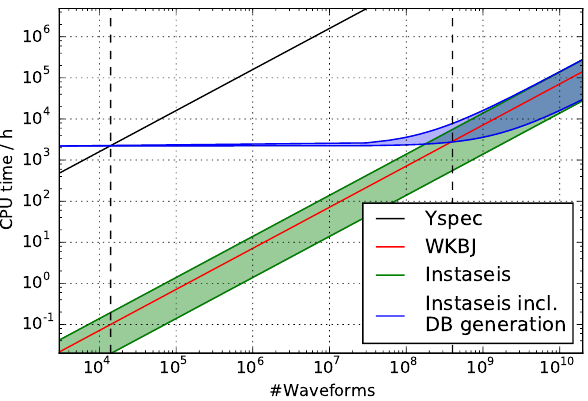
Figure 18. Computational cost to compute many synthetic seismo- grams for finite-frequency tomography with a shortest period of 2s using different methods. For Yspec we assume that for every source there are 1000 receivers with 3 components each. The shaded re- gions for Instaseis indicate the dependence of the performance on the actual source receiver distribution, compare Fig. 16. Including the cost to generate the database with AxiSEM, Instaseis breaks even with Yspec for 14000 waveforms, which is equivalent to about 5 sources in this configuration.